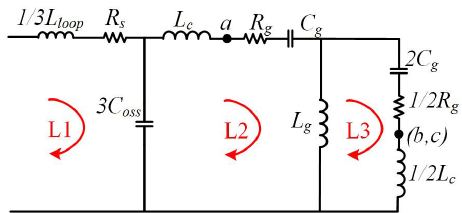
Figure 15. DM equivalent circuit of the motor drive in HF